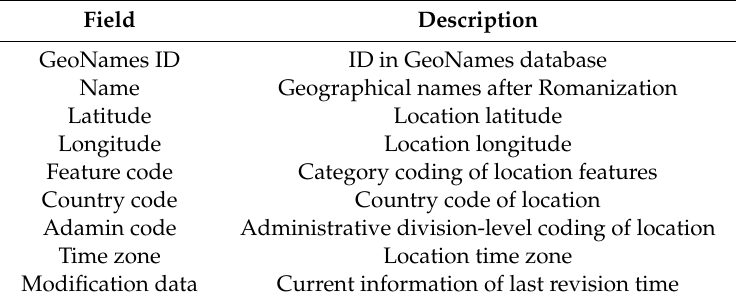
Table 3. Main fields and descriptions of experimental data. Table 5. Main fields and descriptions of experimental data.